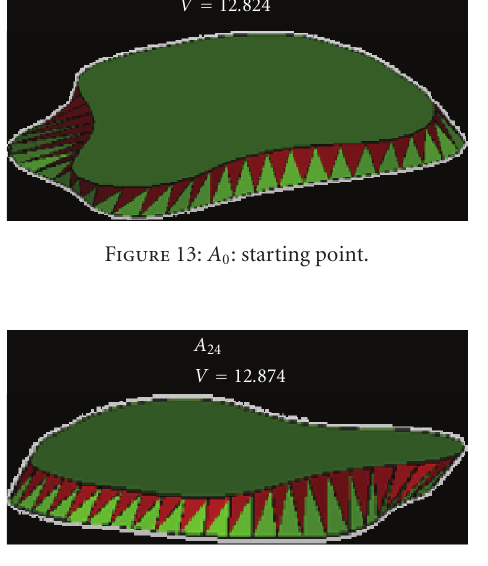
Figure 14: A 24 : starting point—selection of the best triangulation.